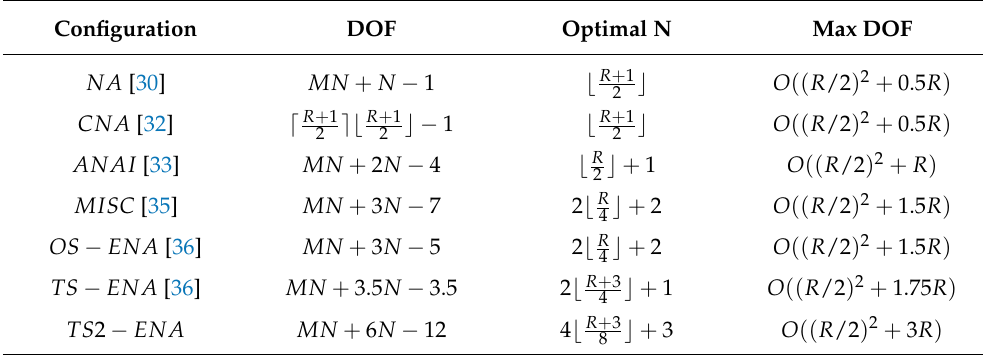
Table 2. DOF comparison of nested-like arrays